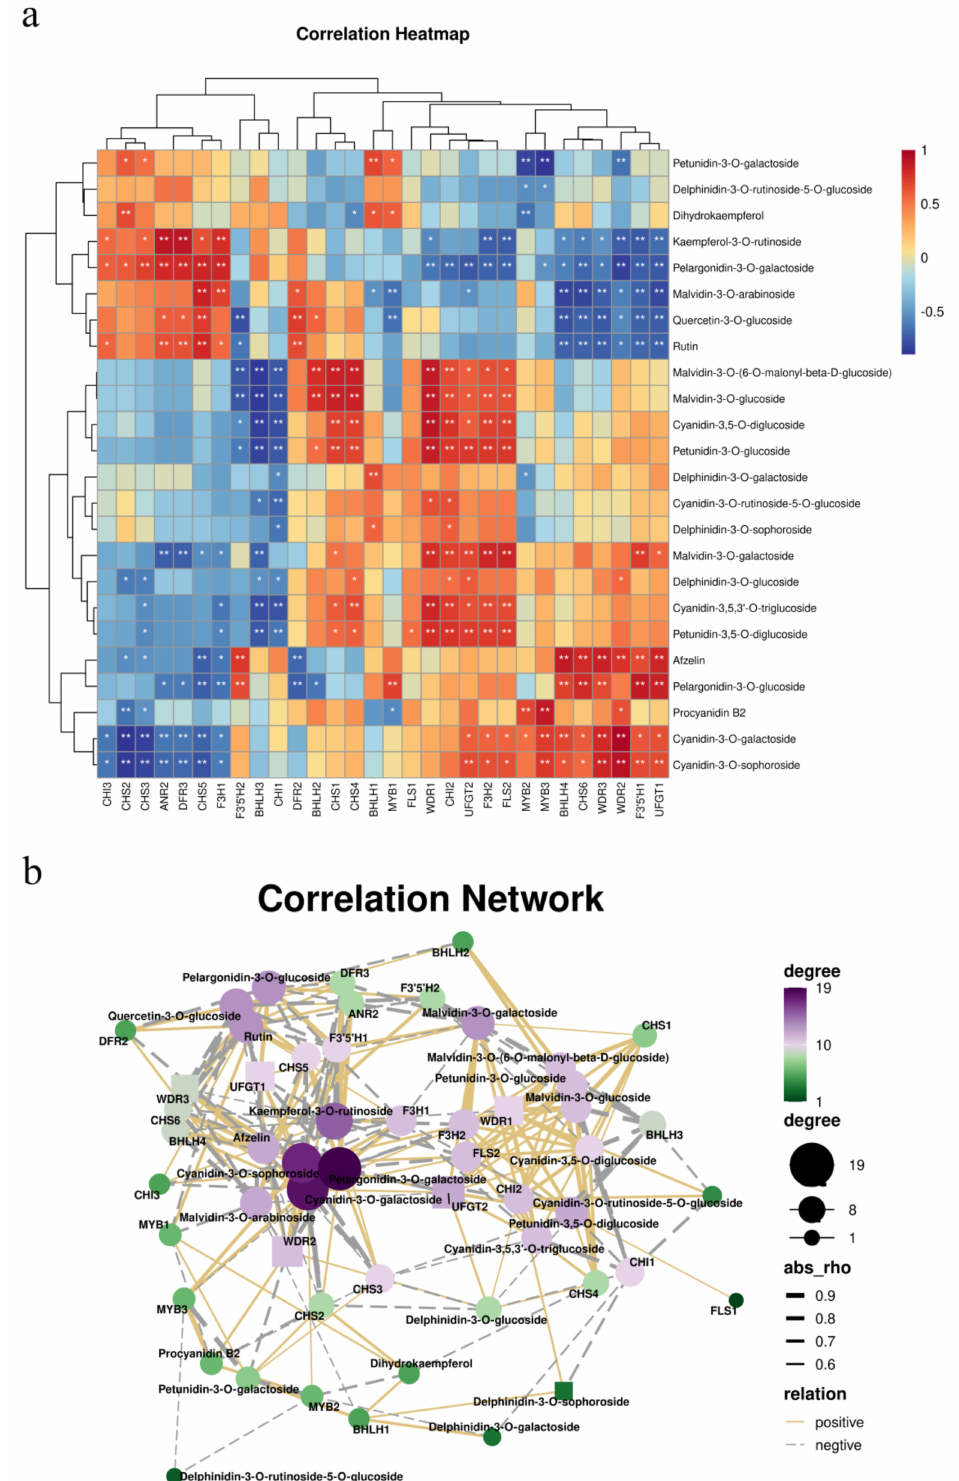
Figure 7. Correlation analysis of the genes related to anthocyanin and differentially accumulated metabolites. ( a ) Heatmap of metabolite abundance according to hierarchical clustering analysis. *: p < 0.05, **: p < 0.01. ( b ) The results of the correlation analysis between anthocyanin genes and differentially expressed